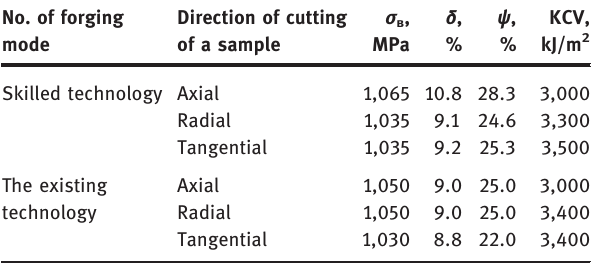
Table 2: Comparative mechanical properties of the forgings made on skilled technology and the existing mode.